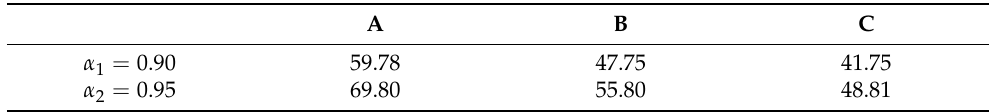
Table 2. Durations in seconds of the shock wave to reach various locations A, B, and C using different values of the fractional order.